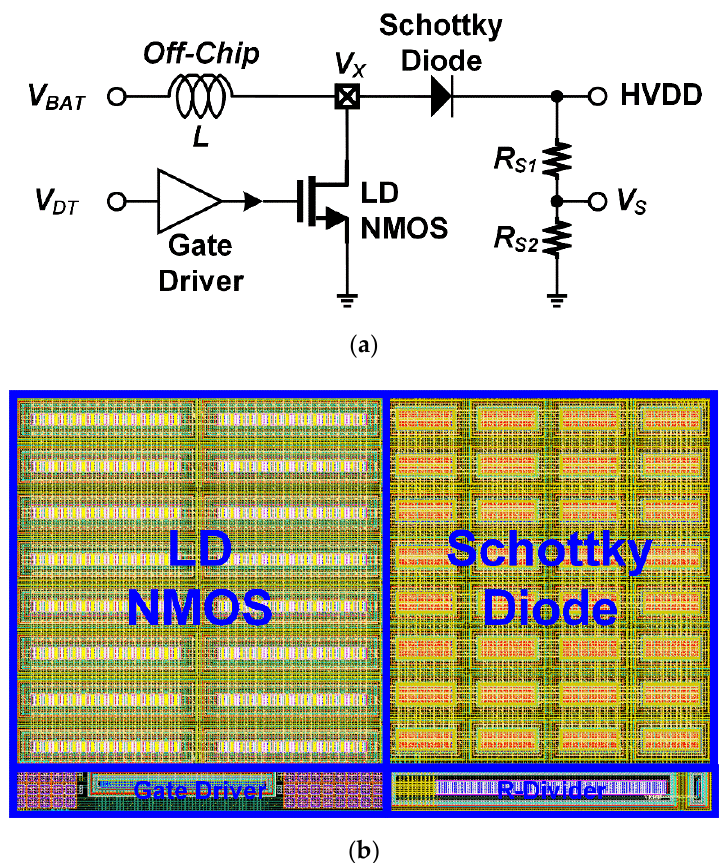
Figure 7. Detailed implementation of power stage: ( a ) schematic; ( b ) layout.